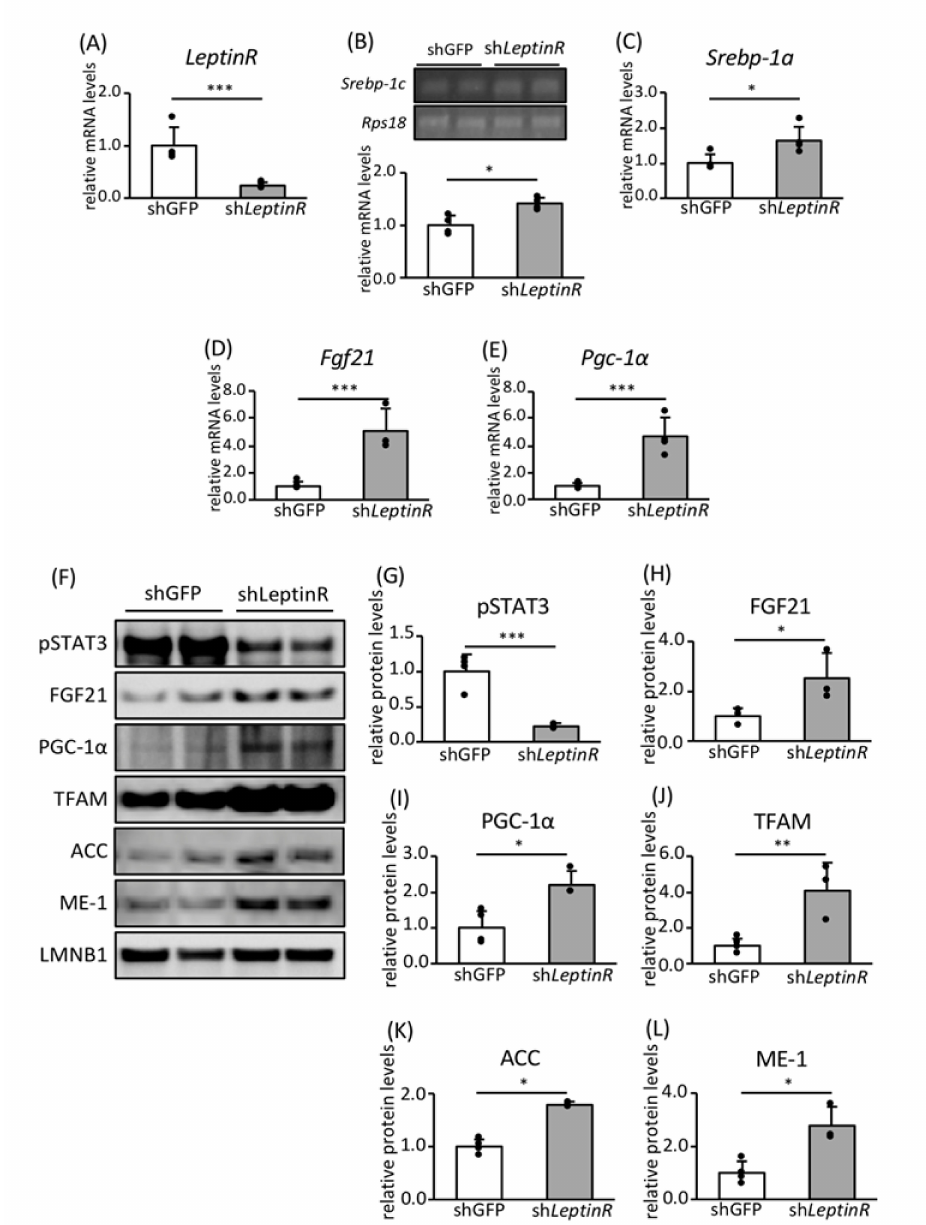
Figure 6. The e ff ects of leptin signaling on the expression of genes and proteins involved in leptin signaling, FA biosynthesis, and mitochondrial biogenesis in mature 3T3-L1 adipocytes. LeptinR knockdown (KD) ( shLeptinR ) and control ( shGFP ) preadipocytes were di ff erentiated into mature adipocytes in four separate dishes for each phenotype, and then RNA was extracted, and lysates were prepared from each dish. The mRNA expression levels of LeptinR ( A ), Srebp-1a ( C ), Fgf21 ( D ), and Pgc-1a ( E ) were determined using RT-PCR and normalized to Rps18 expression ( n = 4). ( B ) Representative images of ethidium bromide-stained gels, showing fluorescence corresponding to the products of Srebp-1c cDNA amplification by RT-PCR. Semiquantitative analysis was performed and the data were normalized to Rps18 expression (n = 4). ( F ) Representative immunoblot images showing the expression of proteins involved in leptin signaling, FA biosynthesis, and mitochondrial biogenesis. Quantitative analysis was performed using a chemiluminescence method. The protein expression of pSTAT ( G ), FGF21 ( H ), PGC-1 α ( I ), TFAM ( J ), ACC ( K ), and ME-1 ( L ) is shown as the relative intensity of the indicated protein divided by that of LMNB1 as an internal control ( n = 4). Values are means ± SDs. * p < 0.05, ** p < 0.01, *** p < 0.001 vs. shGFP, according to Student’s t